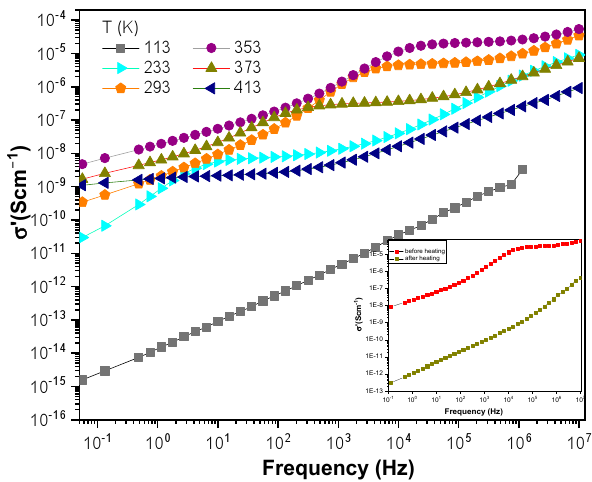
Figure 11. Variations in real part of AC conductivity with frequency at different temperatures for the pure montmorillonite. Inset shows the variation in conductivity at 293 K before and after heating to 433 K.